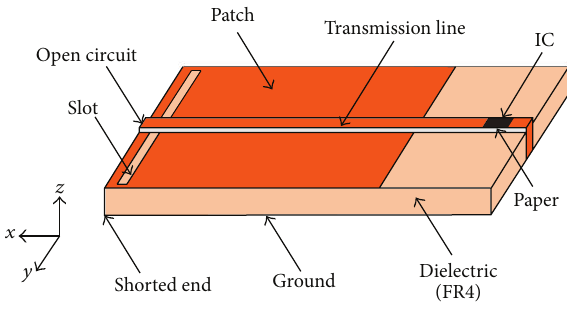
Figure 1: Antenna geometry.